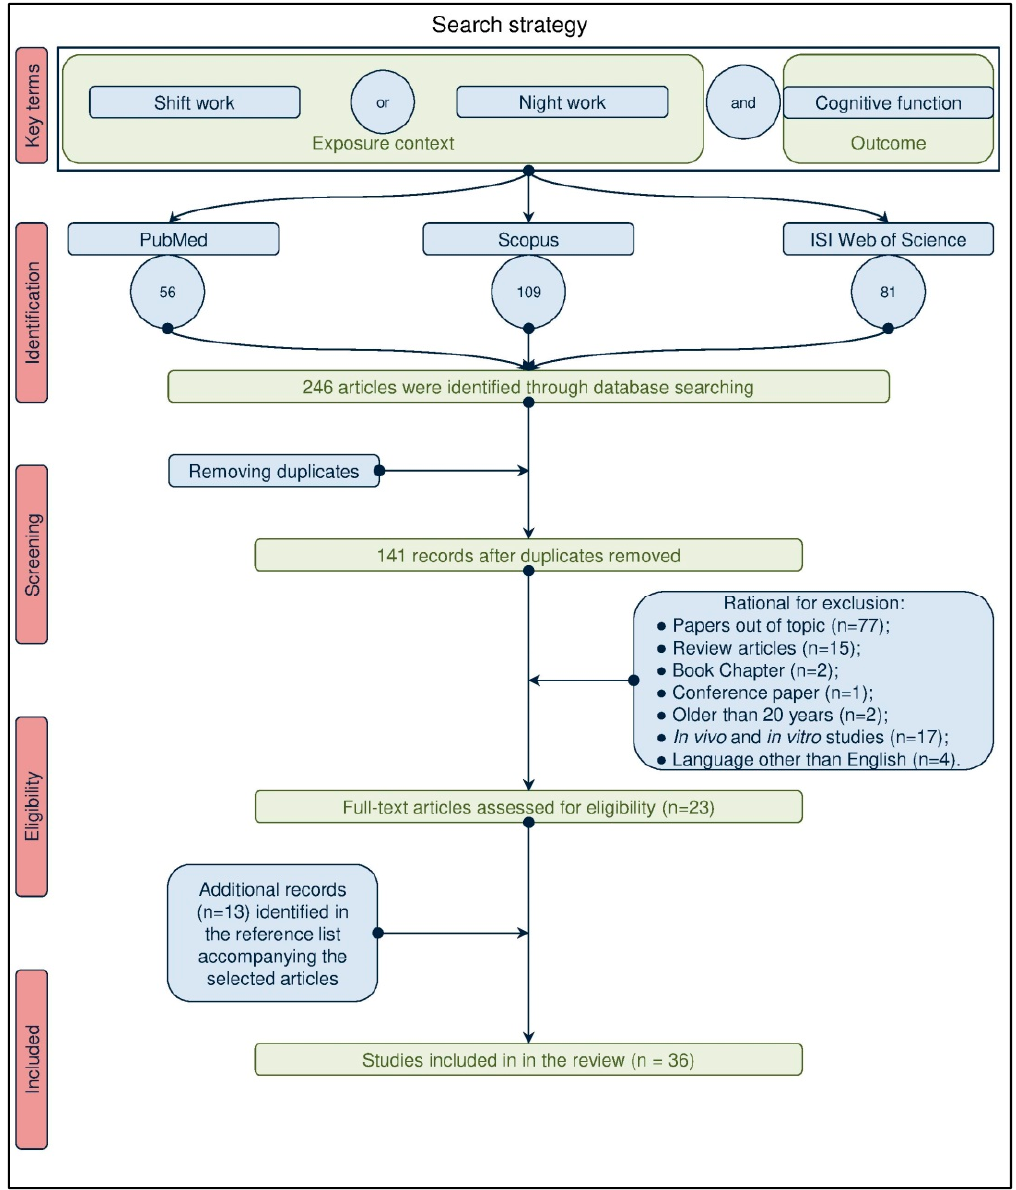
Figure 1. Flowchart of the search strategy used to identify studies of interest.